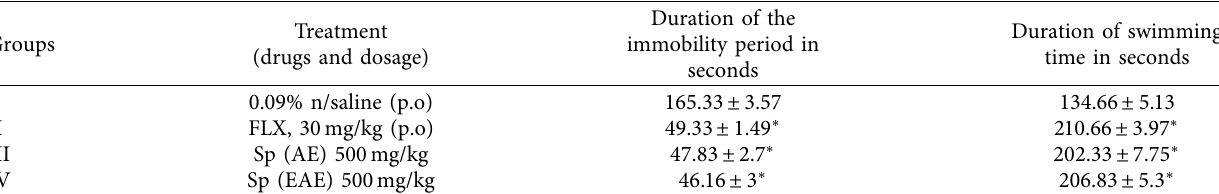
Figure 2: (a) Anxiolytic efect produced by diferent groups upon the number of entries in open and closed arms and (b) anxiolytic efect produced by diferent groups upon the time spent in open and closed arms. Table 3: Efect of Sp extracts in the FST